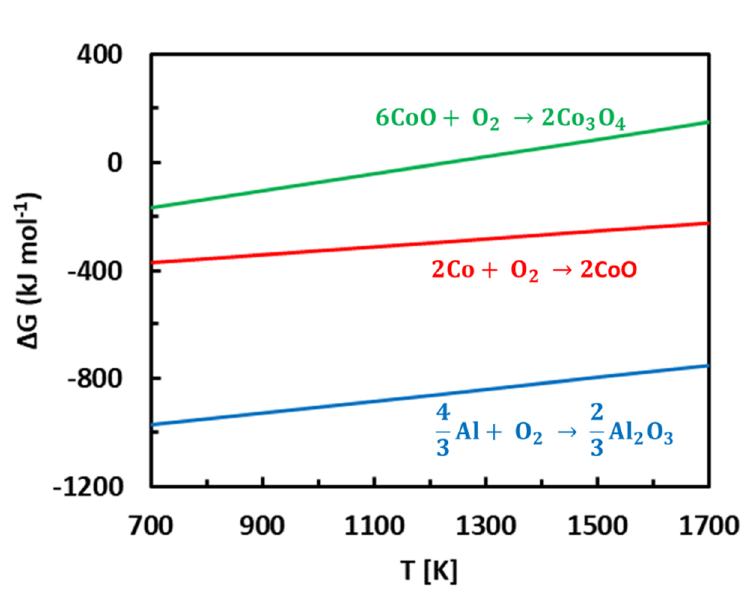
Figure 12. Gibbs free energies of metal oxidation reactions at elevated temperatures, redrawn from [54].